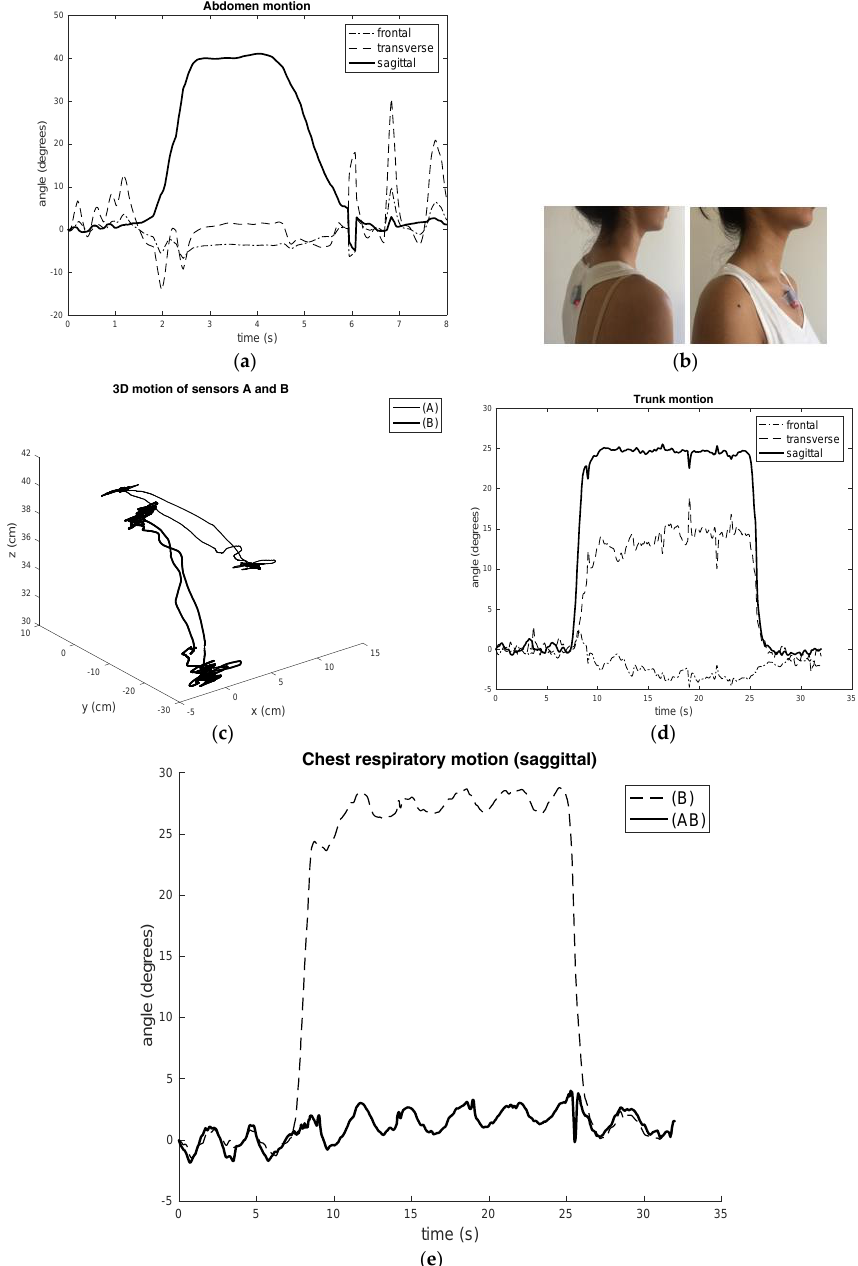
Figure 5. ( a ) Normal breathing accompanied by bending-extending trunk-motion: It was measured using single IMU (inertial measurement unit) located on the abdomen. The abdomen joint angle shows bending motion of trunk in the “Sagittal” plane. Other abdomen angles have minimum deviations showing some noisy breathing signals. The sensor motions show the trunk motion has been reflected in the precision of the respiration signals. ( b ) The pictures show the two IMU sensor placements on the trunk in coherence with that shown in Figure 2a; ( c ) The 3-D Cartesian motions of sensors A and B: The sensor motions clearly show the bending motion has been reflected in the graph. ( d ) Normal breathing accompanied by bending-extending trunk-motion: The hip joint angles show bending motion of trunk in the “Sagittal” plane. Some of the bending trunk motion has been reflected in the “Transverse” plane. The hip joint in the “Frontal” plane shows negligible deviation, as this experiment did not involve bending motion. ( e ) Normal breathing accompanied by bending-extending trunk-motion: The breathing signals and the “Sagittal” motions of sensors A and B: The “Sagittal” plane motion of sensor B shows some breathing signals with a significant bending motions. The very clear breathing motions of ribcage joint angles from sensors A and B (decomposed chest motion with respect to dorsal chest position) in the “Sagittal” plane. Sensor B signals show bend-extend motion (downward-upward deviation, respectively).